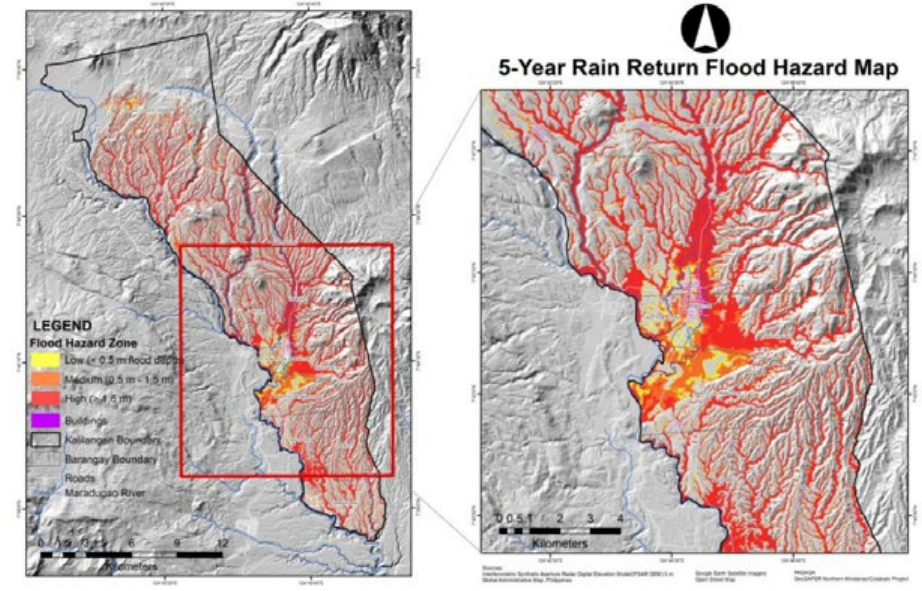
Fig. 4: Flood hazard map of 5-year return period